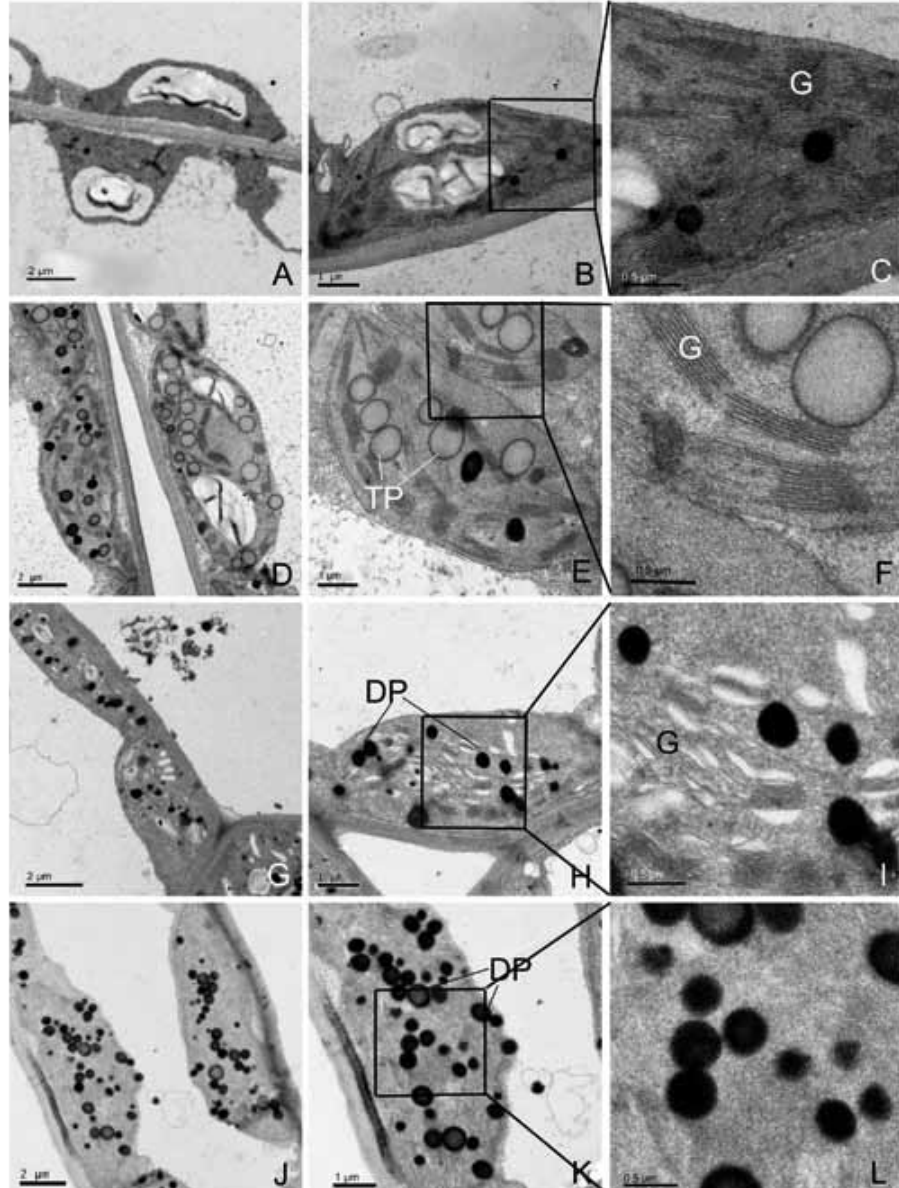
Fig. 4: Ultrastructure of chloroplast in the leaves of M. breviracema at different light intensities. I 10 (A–C), I 30 (D–F), I 50 (G–I), I 100 (J–L). DP: Electron-dense plastoglobules, G: Granum, TP: Electron-transparent